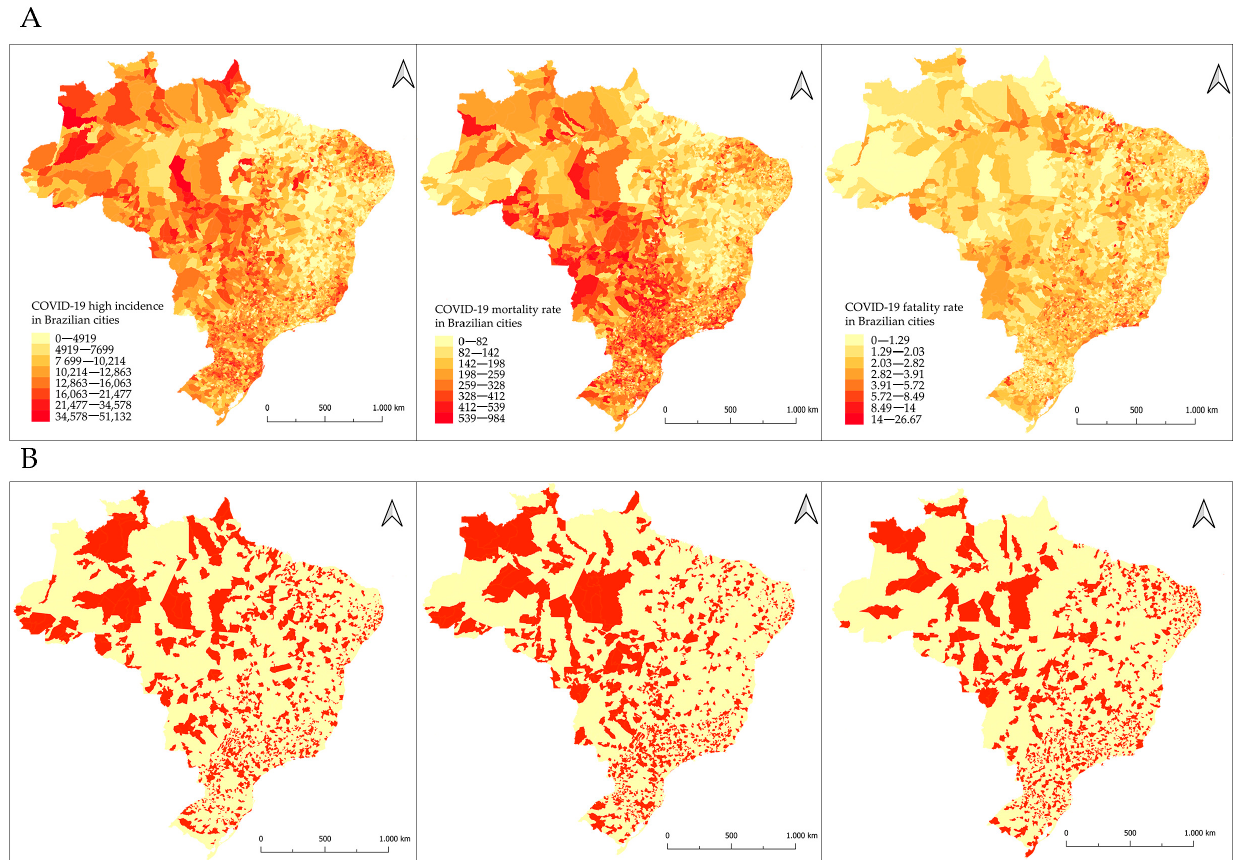
Figure 2. COVID-19 high incidence, mortality, and fatality rates in Brazilian cities ( A ). In ( B ), health indicators above the 75% percentile for COVID-19 in the years 2020 and 2021 in Brazil.